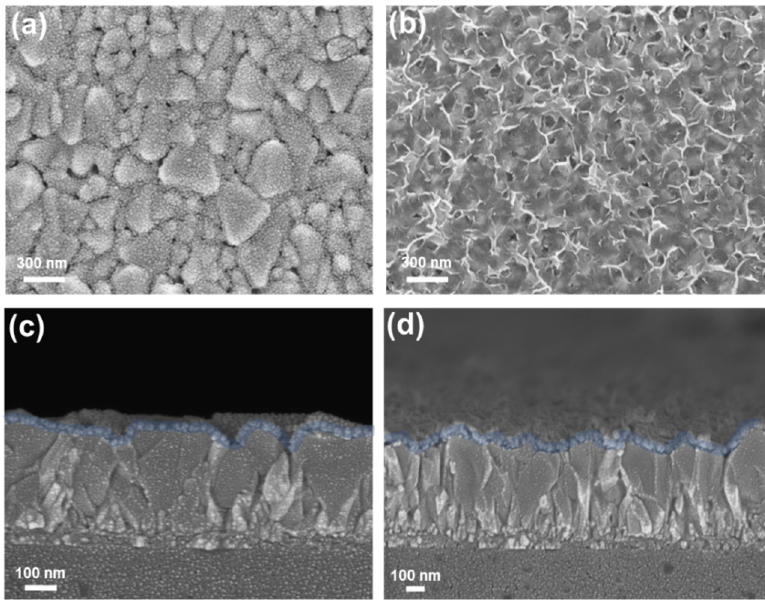
Figure 2. Top-view and cross-sectional SEM micrographs of the NiO x ( a , c ) thin film and ( b , d ) nanoflakes deposited on FTO substrates.